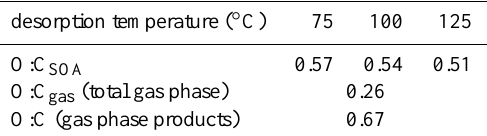
Table 4. Overview of total O:C ratios measured in the particle phase (O:C SOA ) , in the total gas phase (including TMB; O:C gas ) and for the gas phase products (excluding TMB, O:C) after 4h of reaction during experiment 1b.